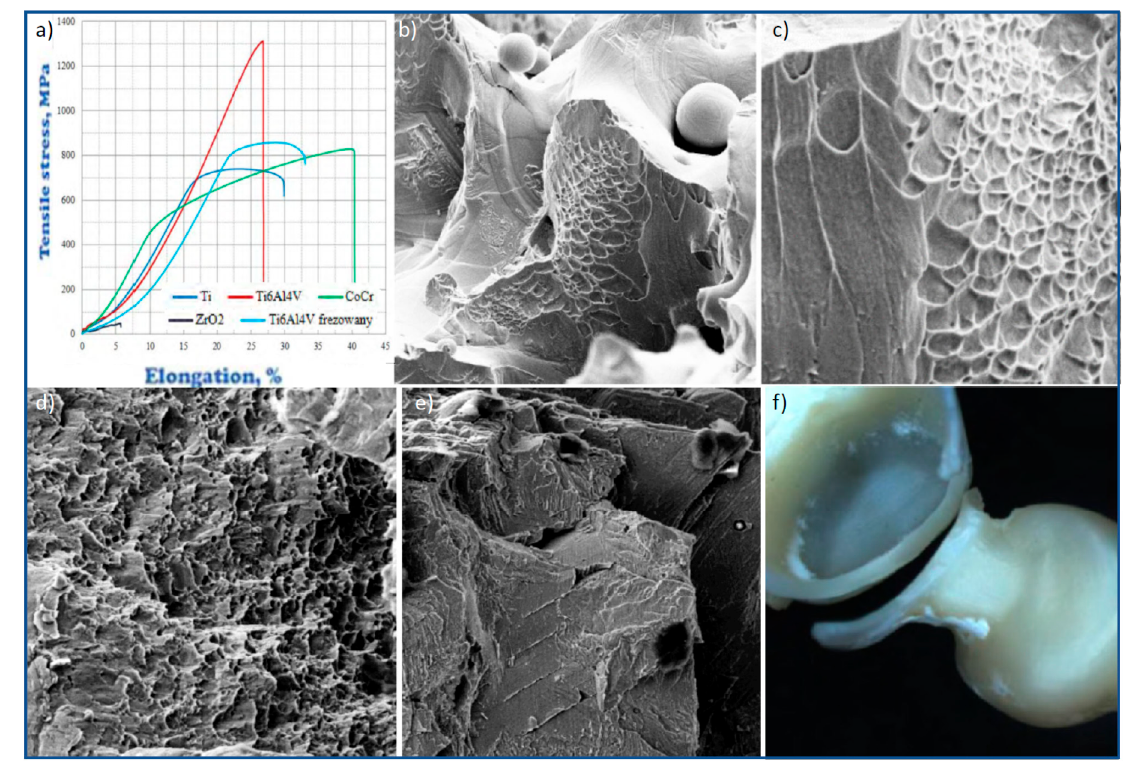
Figure 28. Comparison of the structure and properties of sintered Ti, sintered Ti6Al4V alloy, milled Co-Cr alloy, milled ZrO 2 sinter, and milled Ti6Al4V alloy: ( a ) comparison of the graphs of tensile stress versus elongation; ( b – e ) fracture structure after static bending test ( b , c ) Ti6Al4V solid alloy samples produced by selective laser sintering using a 50 µm laser spot after sintering at laser power ( b ) 70 W; ( c ) 110 W; ( d , e ) samples produced by the CAD/CAM method by milling disks from solid alloys: ( d ) Ti6Al4V, ( e ) Co-Cr; ( f ) view of a dental bridge made of ZrO 2 sinter produced by the CAD/CAM method by milling the disc and then sintered after a static bending test; ( b – e ) scanning electron microscope (SEM); ( f ) stereoscopic microscope.